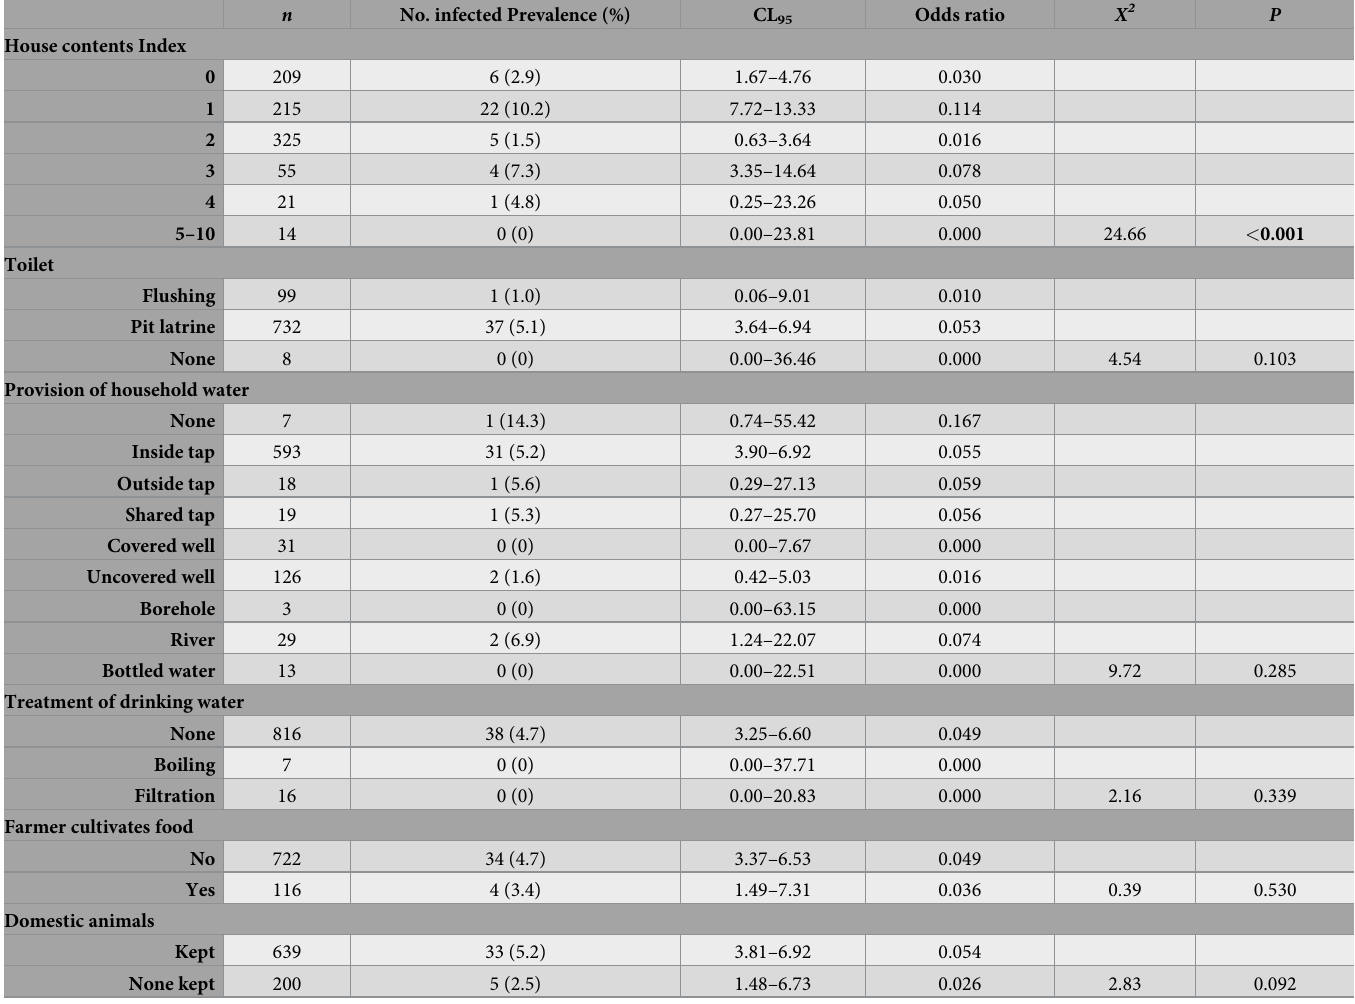
Table 2. Prevalence (%) of Cryptosporiduim infection based on factors in the country of